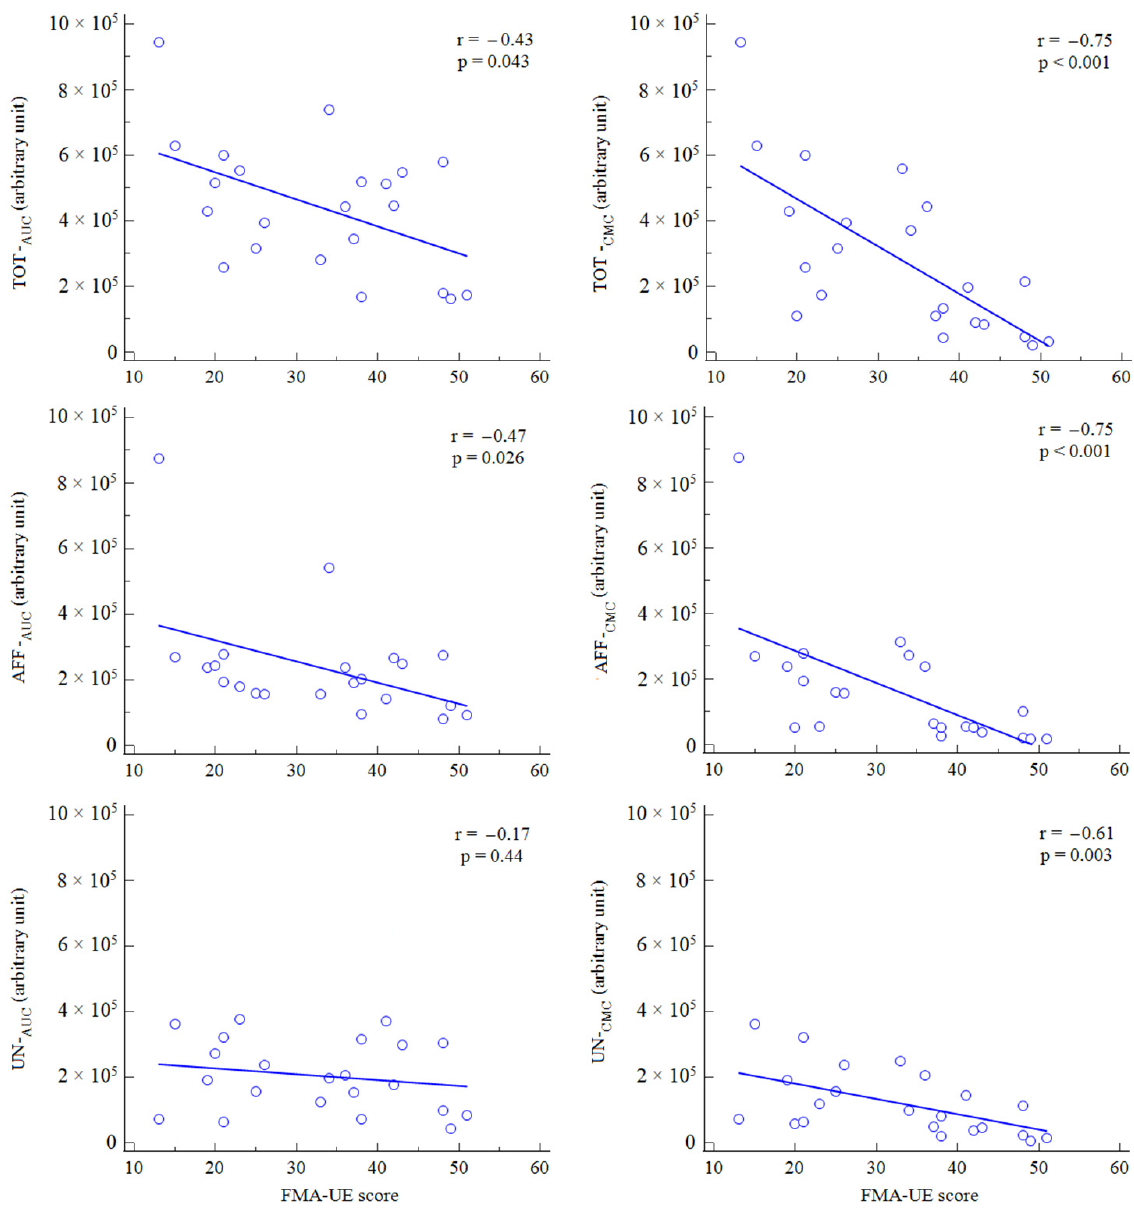
Figure 3. Rank correlation between AUC ( left ) or CMC ( right ) and FMA-UE score at baseline.